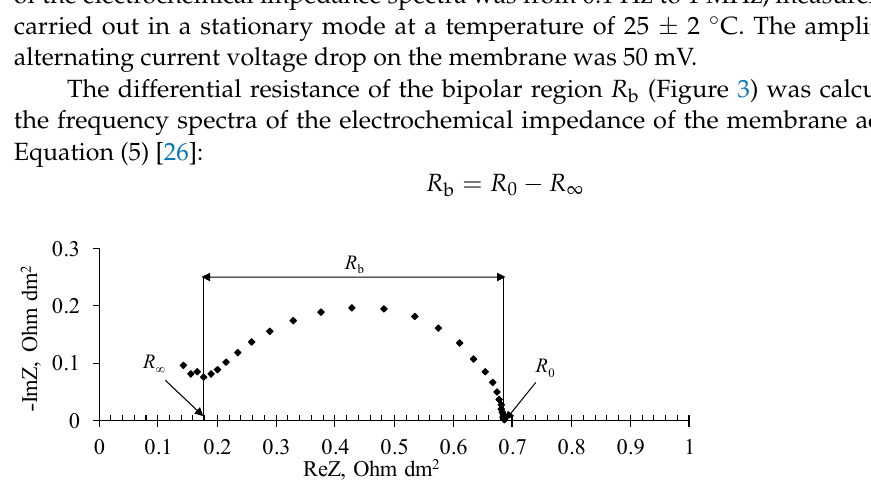
Figure 3. Frequency spectra of electrochemical impedance of bipolar membrane. The overvoltage of the bipolar region of the membrane U b was found by the depen- dence of the differential resistance R b on the electric current density using Equation (6)